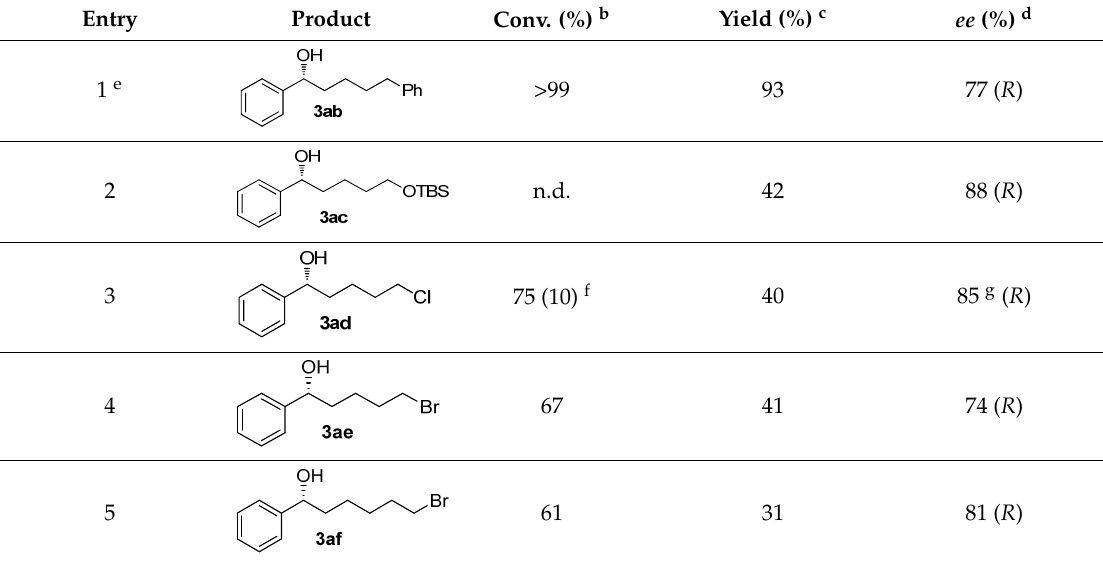
Table 3. Enantioselective catalysed addition of alkenes to benzaldehyde—Scope of the reaction a